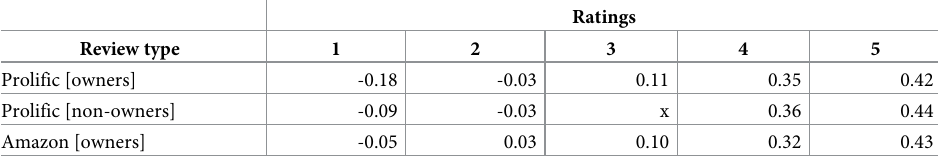
Table 1. Average sentiment scores across reviews and their